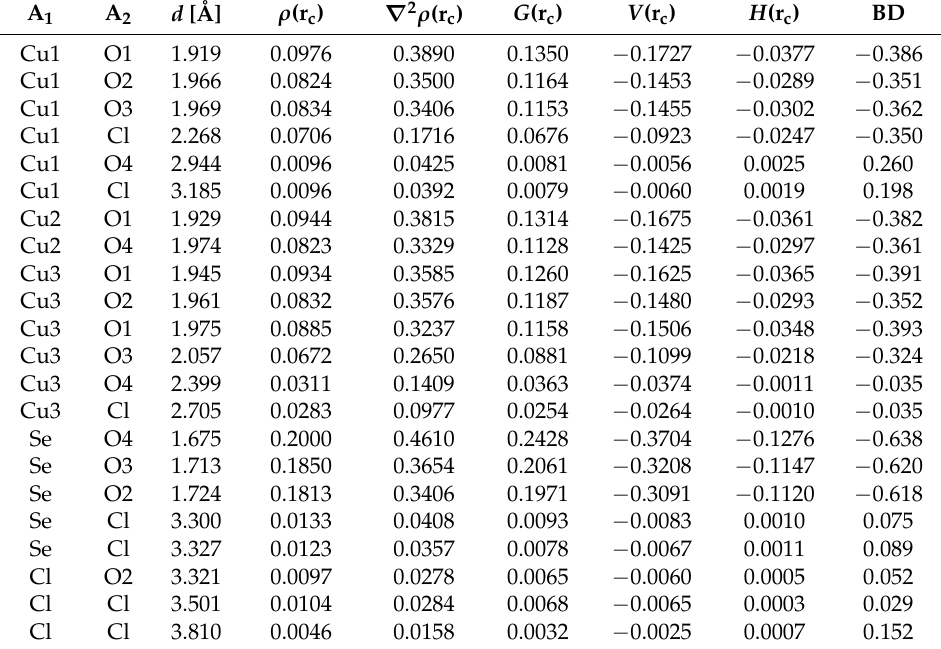
Table 5. Bond critical points in the crystal structure of β -Cu 5 O 2 (SeO 3 ) 2 Cl 2 and their